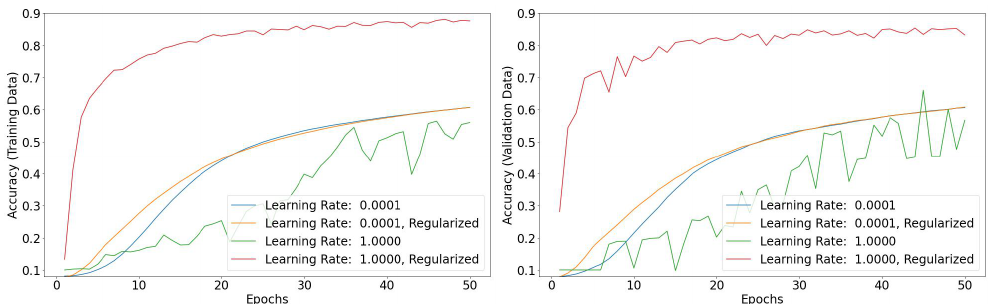
Figure 4. Comparison of accuracy for different learning rates with and without regularization ( left panel shows results for training data, right panel for validation